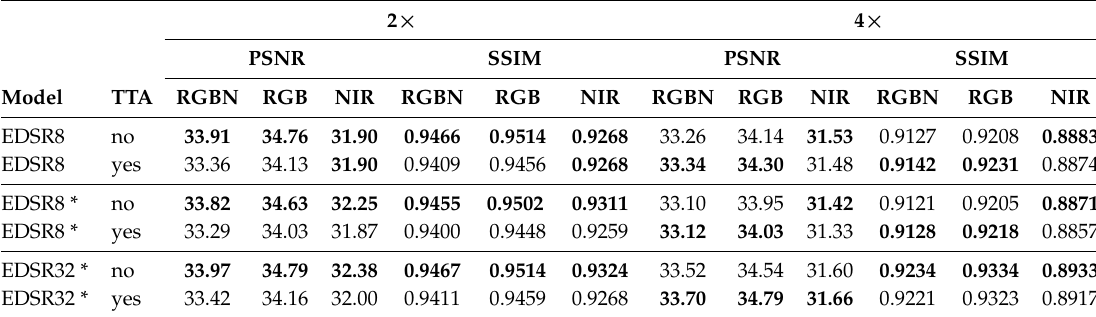
Table 11. PSNR and SSIM metrics obtained with EDSR8 and EDSR32 in the test set using and not using TTA. 2 × 4 × PSNR SSIM PSNR